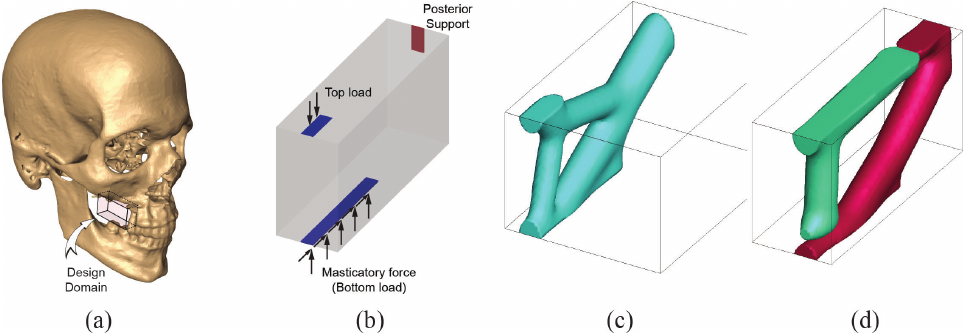
Figure 9. Case 3. ( a ) Extraction of design domain from patient CT scan, ( b ) boundary condition used in the analysis, ( c ) bone replacement shape using single material topology optimization, ( d ) bone replacement shape using multi-material (2 materials) topology